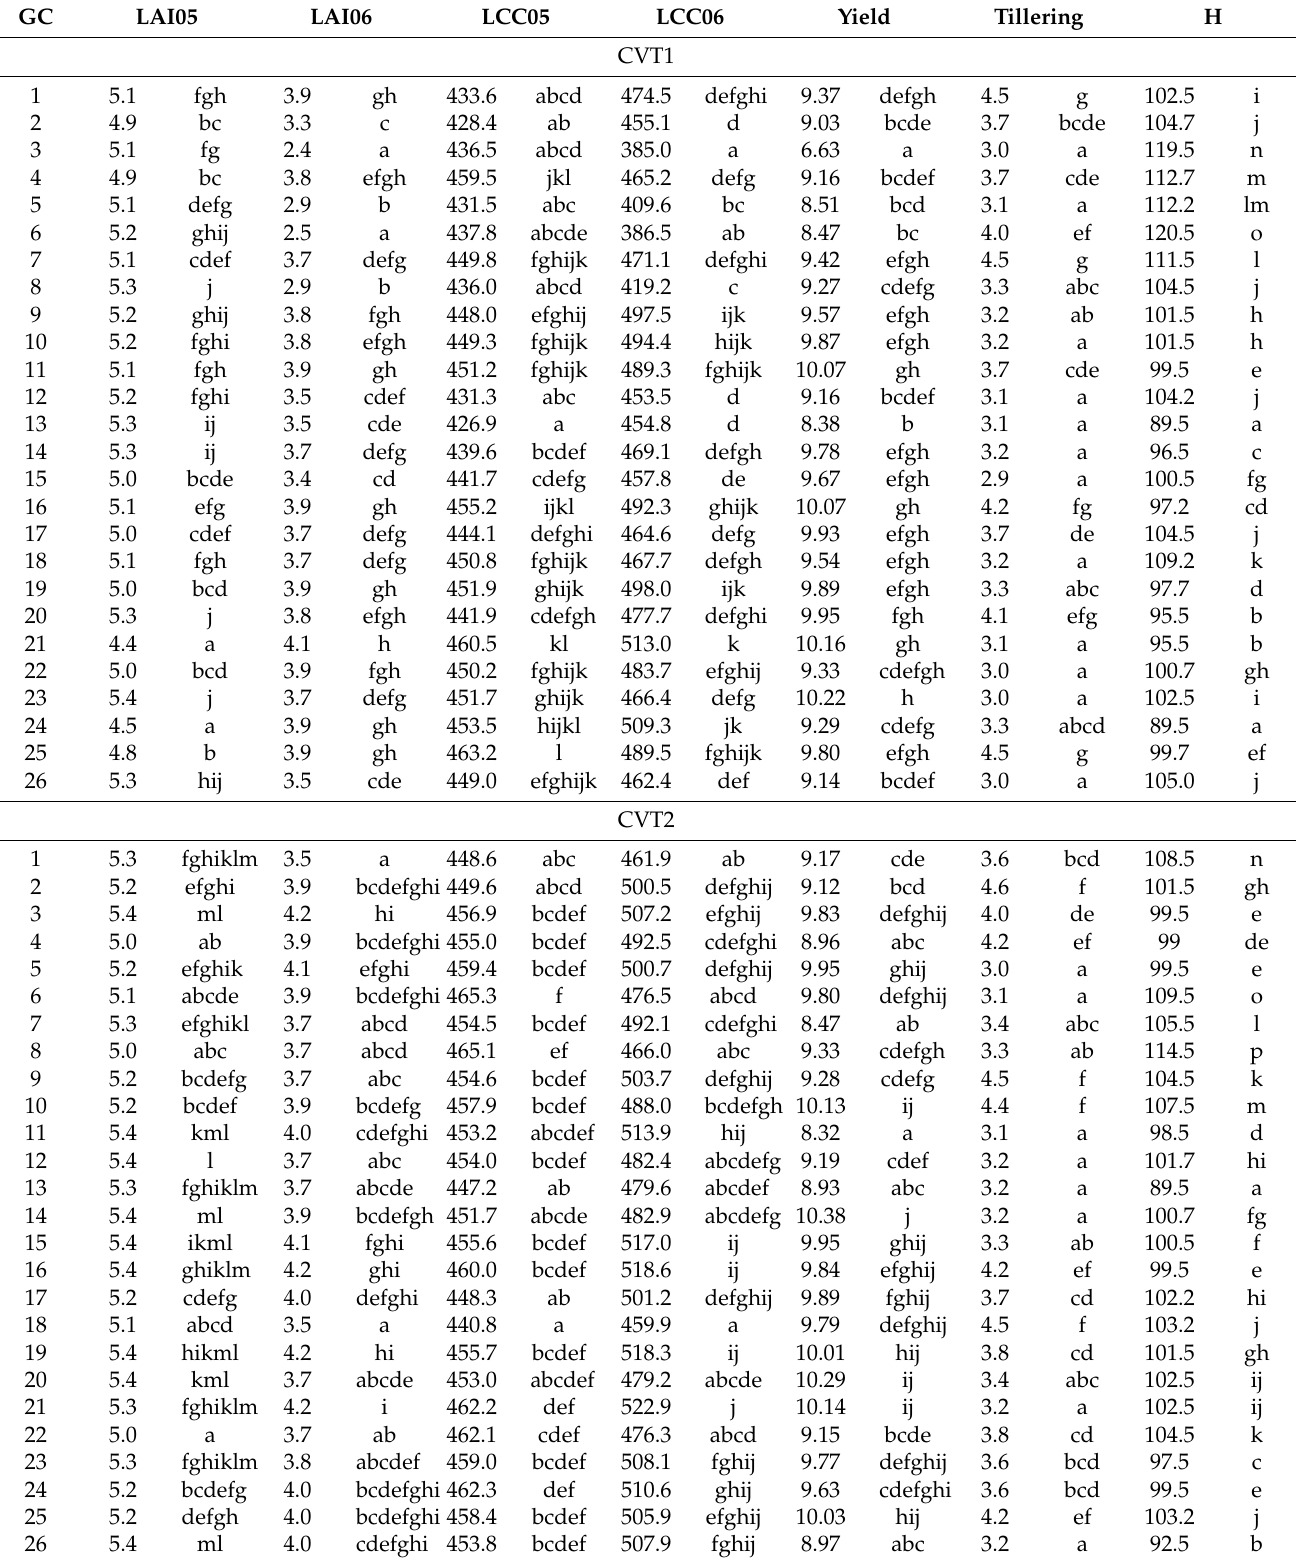
Table A4. Mean values and DMRT for LAI05, LAI06, LCC05, LCC06, grain yield (GY), tillering (T), and plant height (H) for CVT1 and CVT2. Mean values (in each column) followed by the same letters have no proven differences at p < 0.05 according to DMRT. GC: genotype